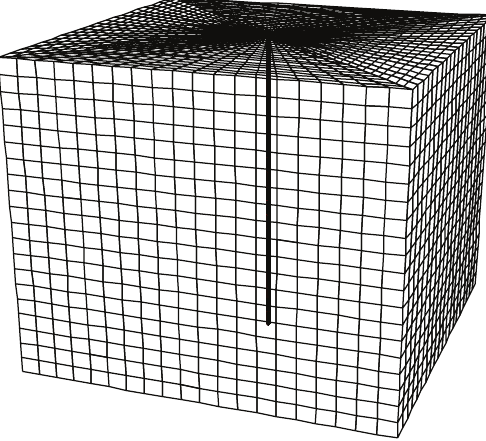
Figure 7: The 3D model in FLAC3D.